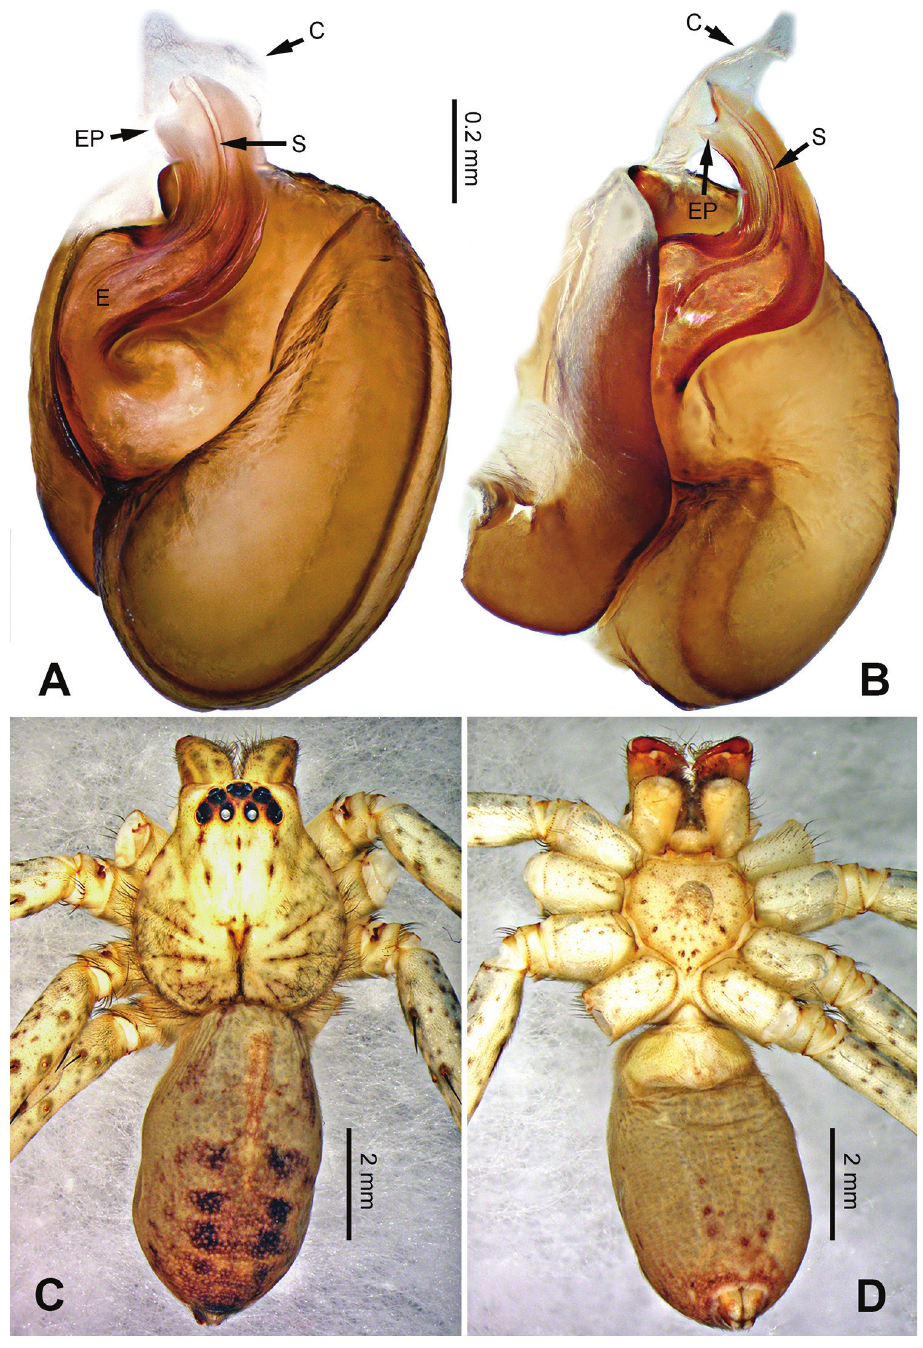
Figure 2. Pseudopoda chayuensis Zhao & Li, sp. n., male holotype. Right bulb horizontally flipped for the sake of comparison. A Bulb, ventral view B Bulb, dorsal view C Habitus, dorsal view D Habitus, ventral view. Scale bar equal for A, B